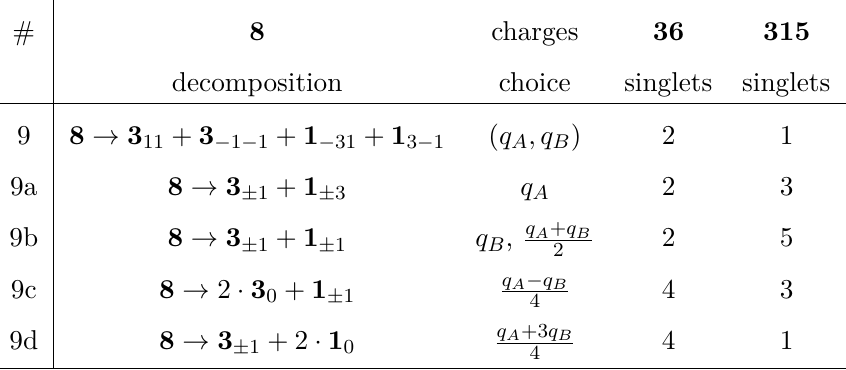
Table 2 . Branchings for the case